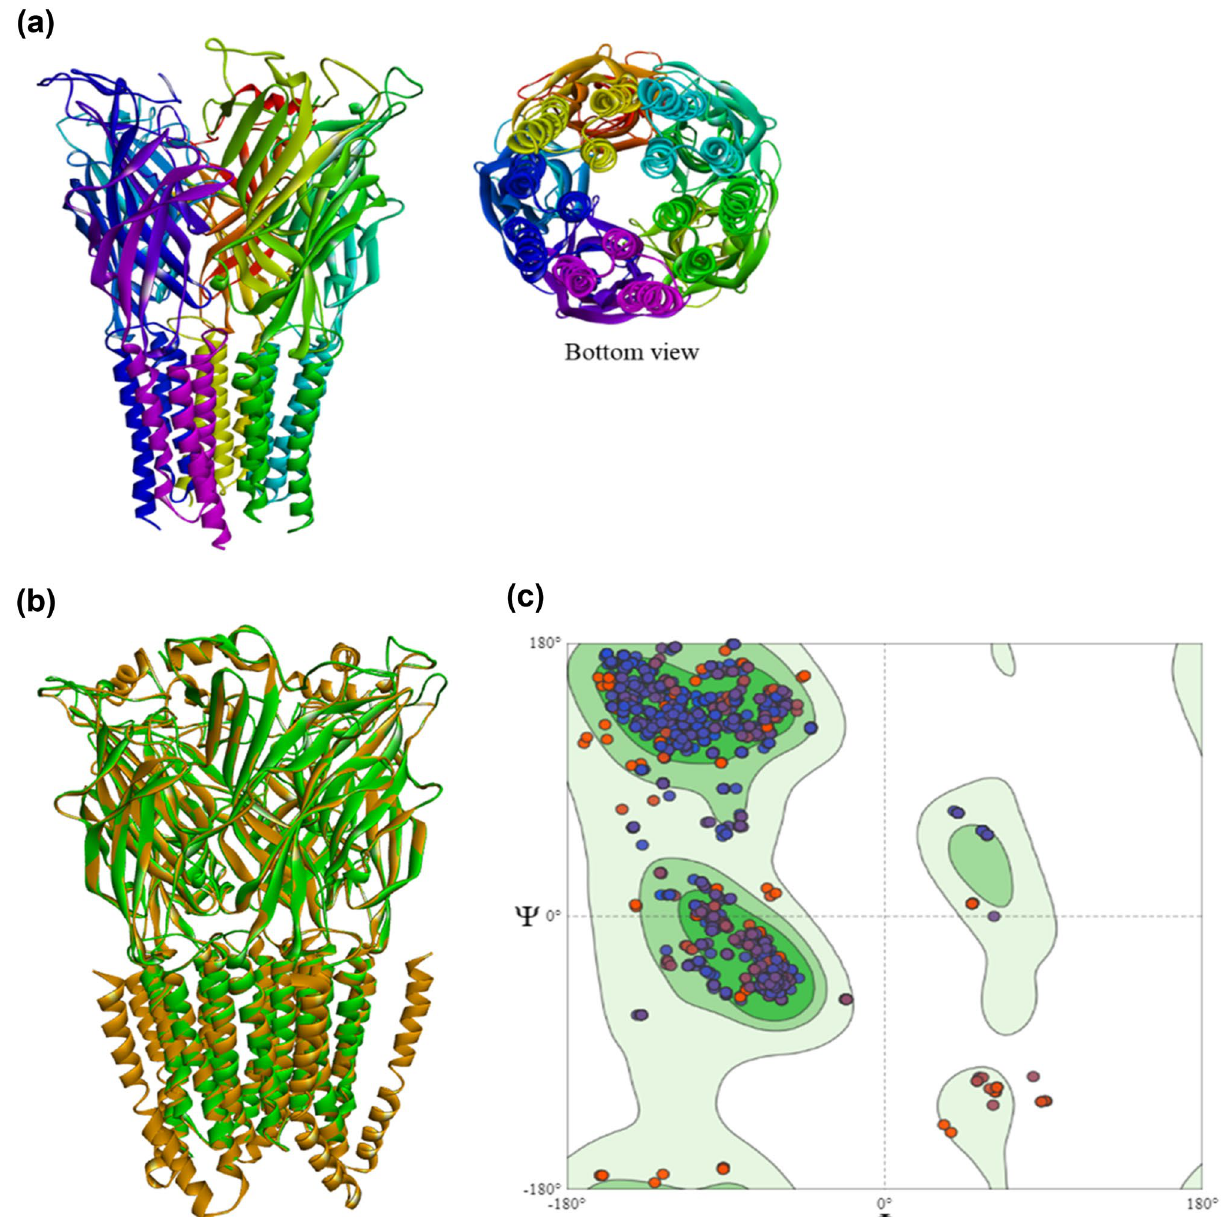
Figure 6. Homology modelling of Bursaphelenchus xylophilus α glutamate-gated chloride channel (GluCl) receptor. ( a ) Three-dimensional (3D) model of B . xylophilus α GluCl receptor obtained through homology modelling. ( b ) Superimposed 3D structures of α GluCl receptor from B . xylophilus (green) and C . elegans (brown). ( c ) Ramachandran plot showing the quality assessment of B . xylophilus α GluCl receptor 3D